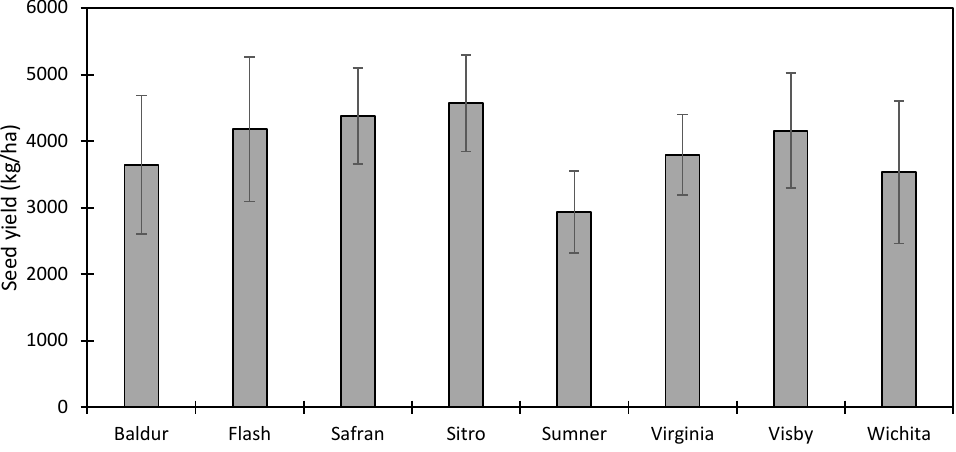
Figure 4. Average and standard deviation of winter canola seed yield for the 2008–2013 period. Table 2. Canola seed yield, nitrogen use efficiency, irrigation and crop water use efficiencies. Parameters